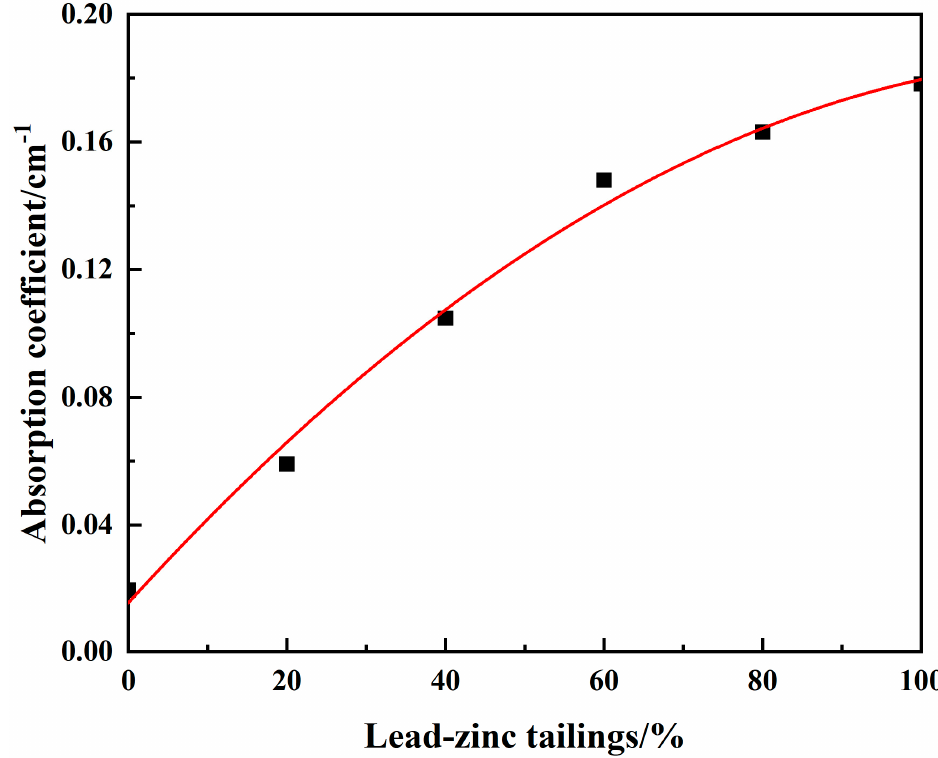
Figure 10. Relationship between γ -ray absorption coefficient of concrete and different contents of lead–zinc tailings